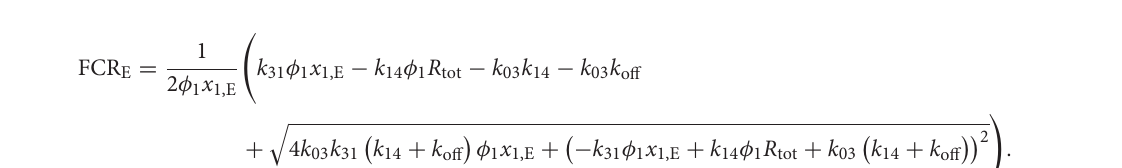
FIGURE 5 | Timecourse data [ y 1 ( t ) blue circles; y 2 ( t ) red circles] and model fits [ y 1 ( t ) blue line; y 2 ( t ) red line] for (A–F) subjects